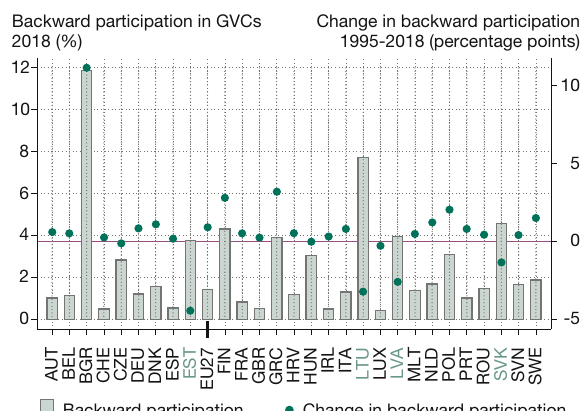
Interdependence between Russia and the EU member